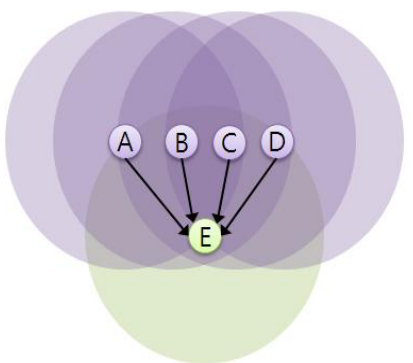
Figure 4. Parent nodes sharing a